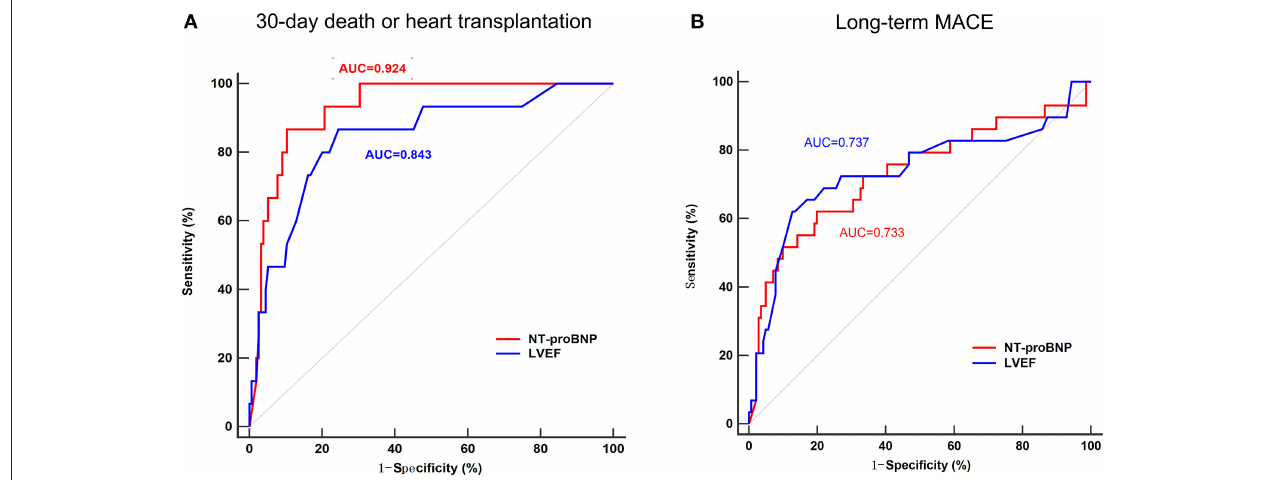
FIGURE 2 | Receiver operating characteristic (ROC) curve of the ability of NT-proBNP and LVEF to predict 30-day death or heart transplantation (A) and long-term MACE (B) in patients with acute myocarditis. In predicting 30-day death or heart transplantation, the area under the curve (AUC) for NT-proBNP was 0.929, with 86.67% sensitivity and 89.68% specificity, while the AUC for LVEF was 0.843, with 86.67% sensitivity and 75.48% specificity. In predicting long-term MACE, the AUC for NT-proBNP was 0.733, with 62.07% sensitivity and 80.14% specificity, while the AUC for LVEF was 0.737, with 62.07% sensitivity and 87.23% specificity.